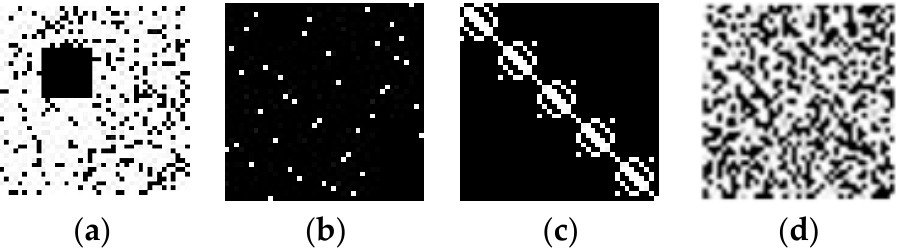
Figure 12. QR code reconstruction from selectively tampered share ( a ) S 1 (6th QR code), ( b ) S 2 (6th QR code), ( c ) S 3 ( 6th QR code), ( d ) reconstructed QR code.